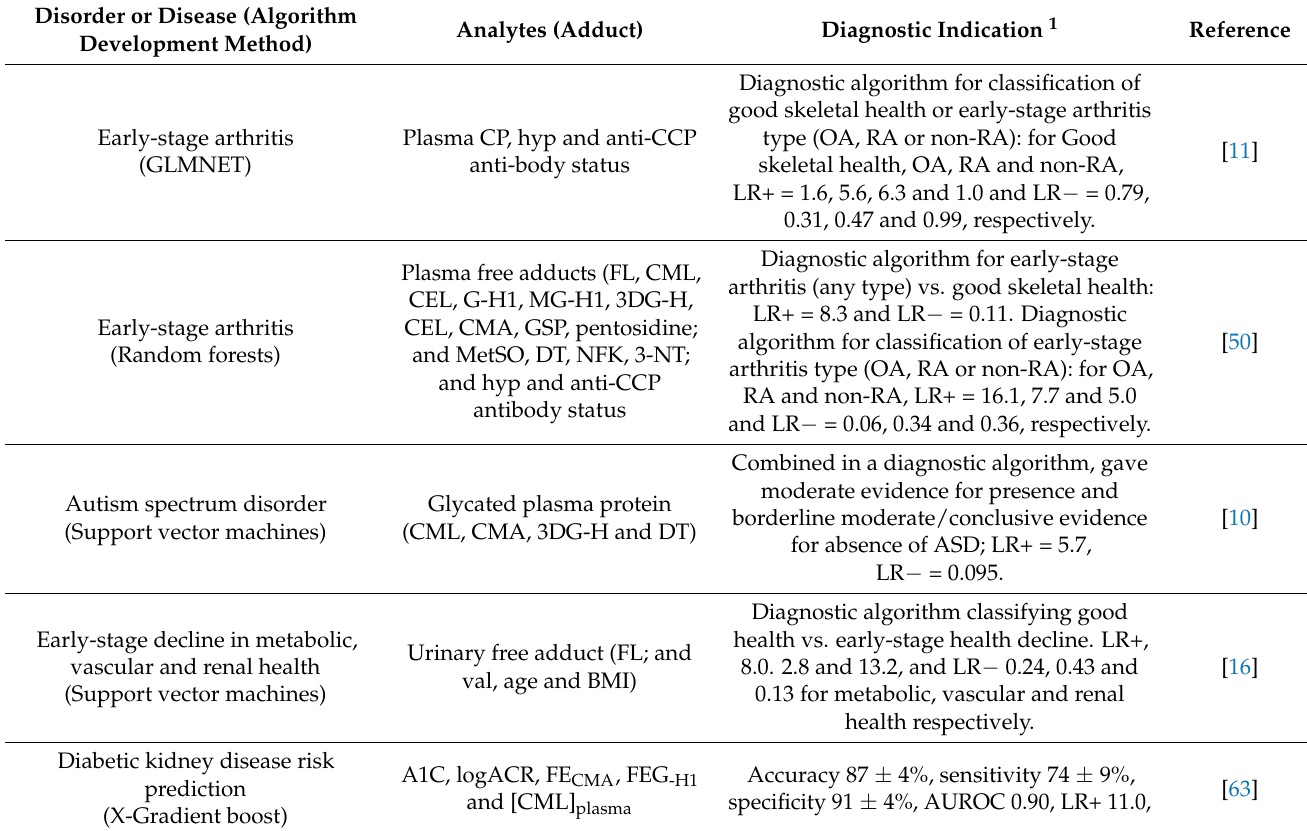
Table 2. Diagnostic algorithms developed with the AGEomics